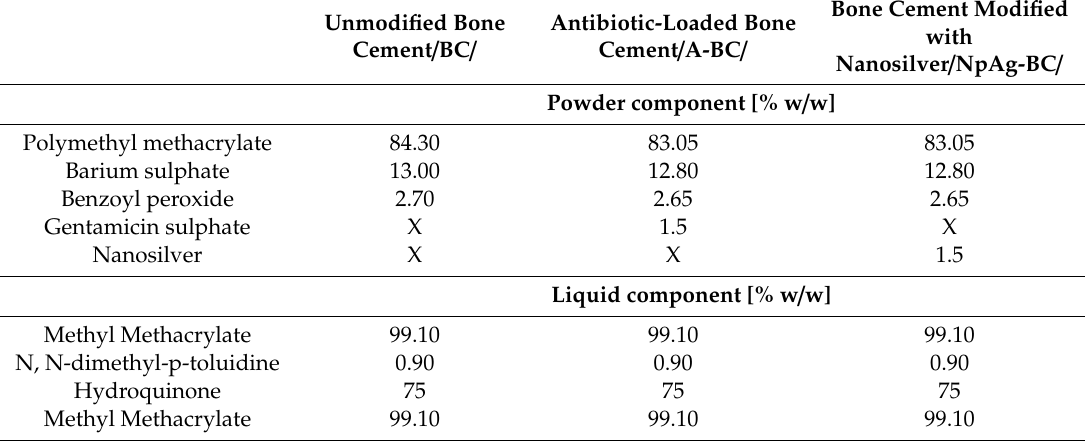
Table 1. Chemical composition of bone cements used for titanium specimens coating.